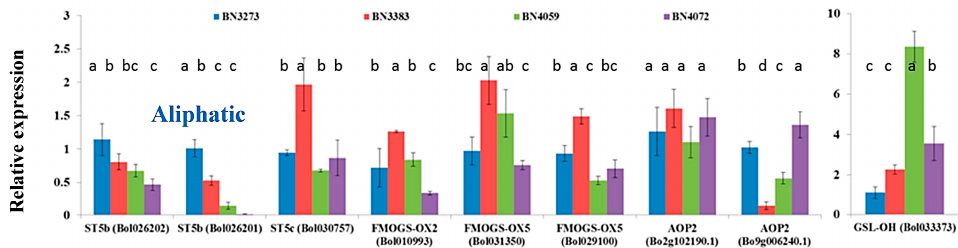
Figure 4. Relative expression level of aliphatic glucosinolate biosynthesis-related genes in four cabbage inbred lines of B. oleracea . Vertical bars indicate the standard deviation of the means of nine observations. Different letters (a, b, c) indicate statistically significant difference between inbred lines. Four indolic biosynthesis-related gene accessions, namely ST5a (Bol039395), CYP81F2 (Bol012237), CYP81F2 expression for the cabbage line BN3383 compared to the control line BN3273 (Figure 5, Table S2). The inbred line BN4059 coupled with BN3383 accounted for approximately a four-fold higher expression level of the CYP81F3 (Bol028919) and CYP81F4 (Bol032714) genes compared to the two other cabbage